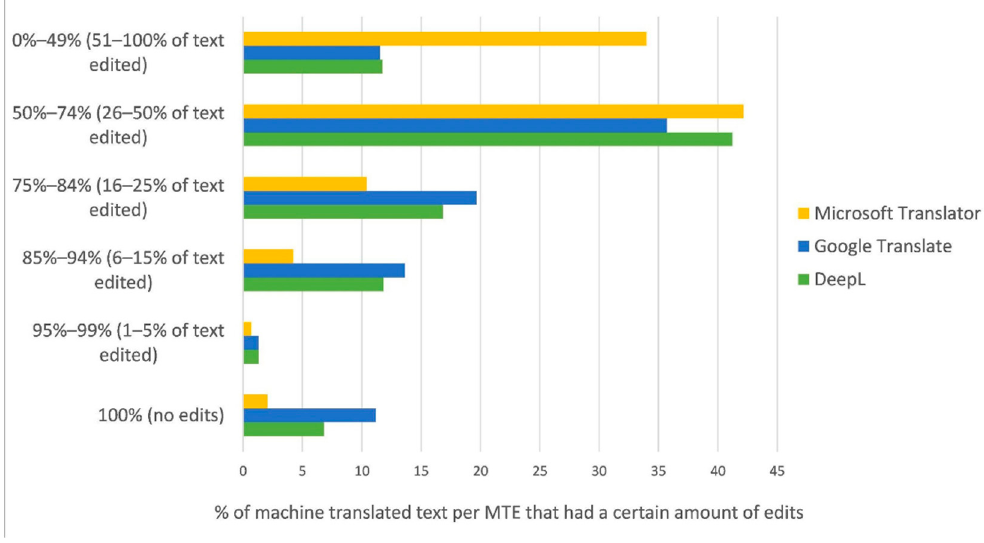
Figure 2. Percentage of machine translated text per MTE after two consecutive human post-editing steps. Google Translate and DeepL are shown to have had more MT output with fewer edits (no edits or up to 25% of text edited), whereas Microsoft Translator had more MT output that required more substantial edits.